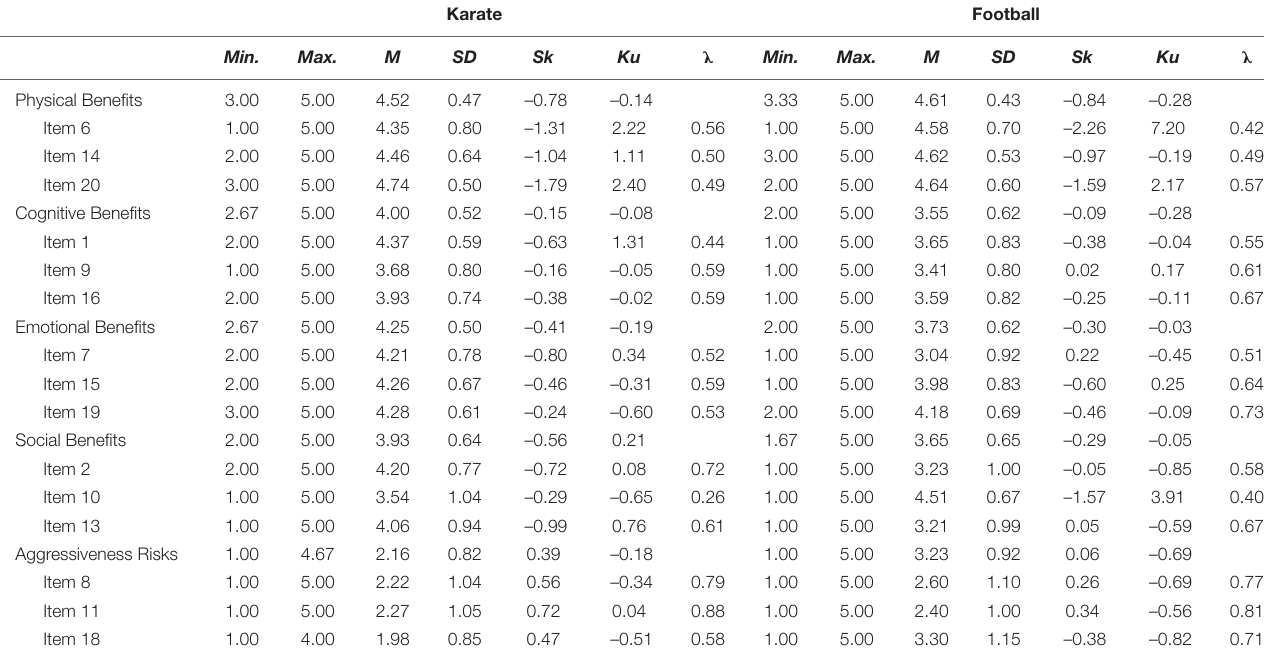
TABLE 2 | Descriptive statistics, including factor loadings, of the retained karate and football items.